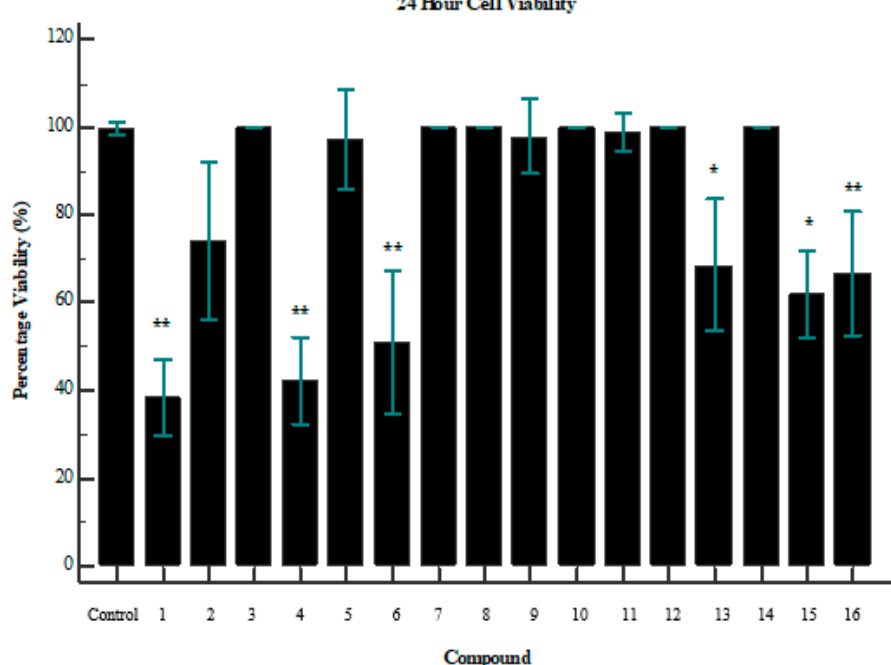
Figure 3. Cell viability of tested compounds after 24 h; where the p -value is indicative of the statistical significance versus the control, using an independent two-tailed T-test ( n = 3). * p < 0.05, ** p < 0.01. Compounds 1 ( p = 0.0056), 4 ( p = 0.0017), and 6 ( p = 0.0060) showed the greatest impact on cell viability.